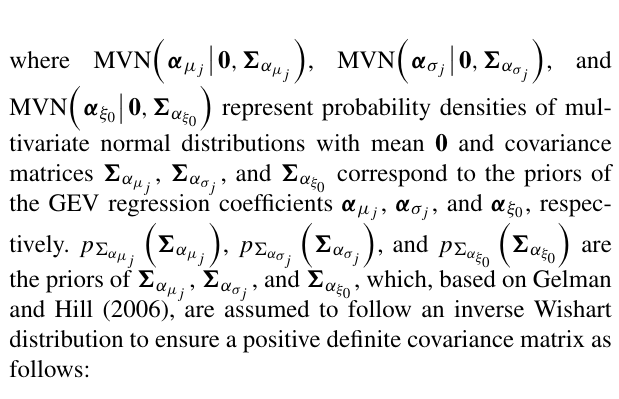
Figure 1. Conceptual sketch of the Bayesian hierarchical model. Blue boxes denote the data, orange boxes the GEV distribution parameters, gray boxes the models, and red circles the inferred quantities. Model boxes correspond to the data layer (Gaussian copula and GEV marginal distributions) and the latent layer (time regressions of GEV parameters). θ (cid:0) s i ,t j (cid:1) = (cid:2) µ (cid:0) s i ,t j (cid:1) , log σ (cid:0) s i ,t j (cid:1) ,ξ (cid:0) s i ,t j (cid:1)(cid:3)